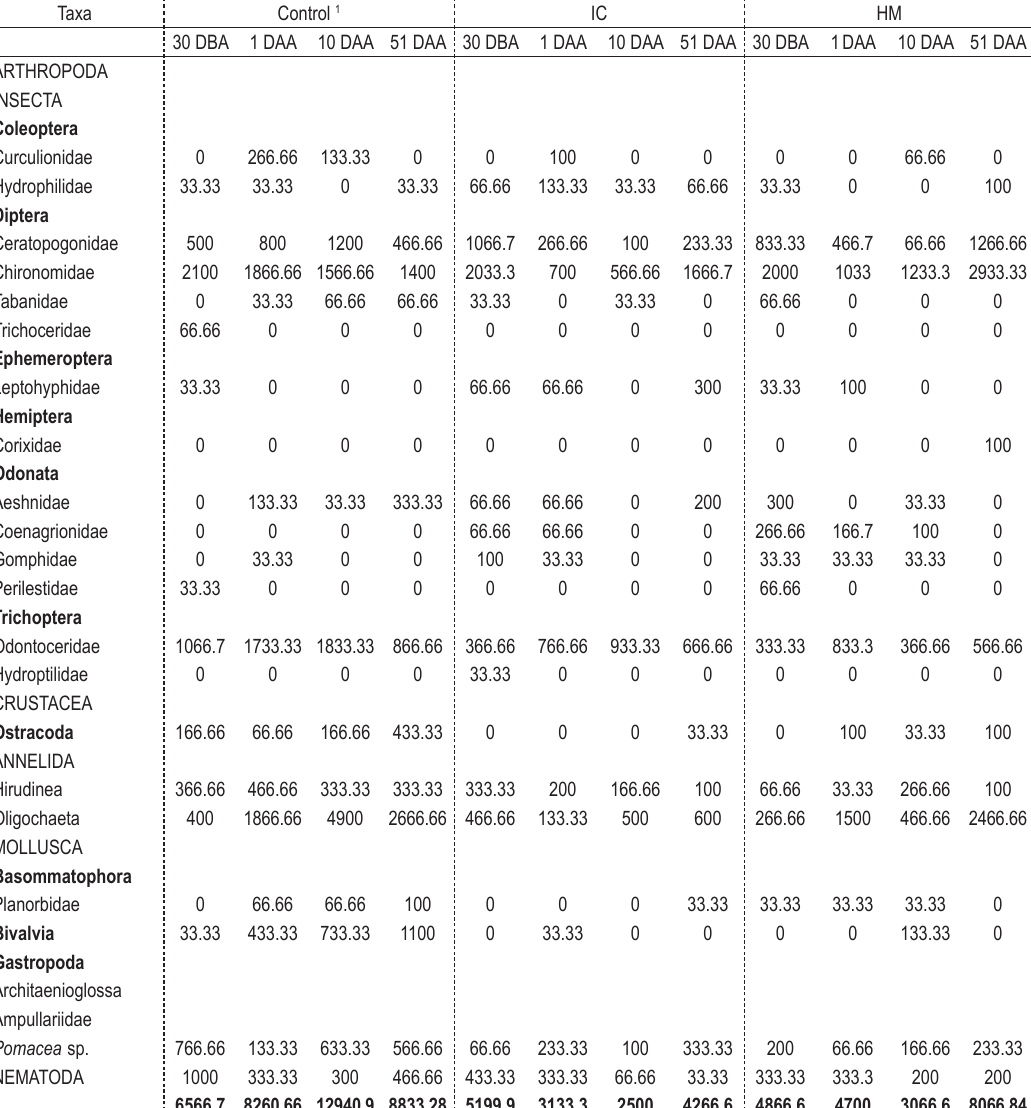
Table 2. Mean density of organisms per m² in each treatment and at each sampling time. Santa Maria, Rio Grande do Sul, Brazil, 2006.